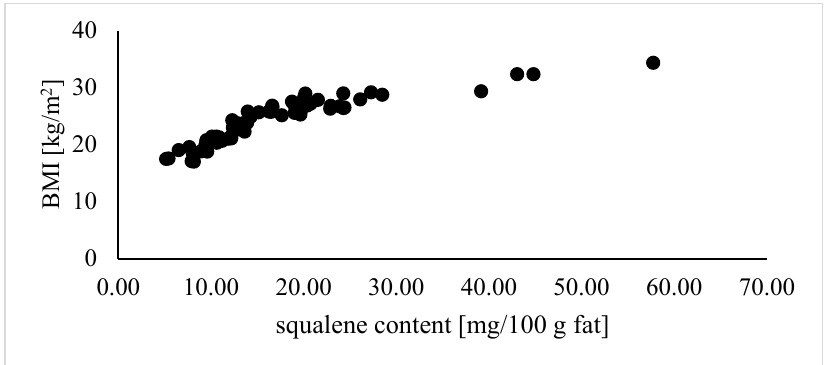
Figure 3. Correlation coefficients (r) calculated for the relationship between the BMI of lactating women and squalene content in human milk (correlation: r = 0.78). Table 2. Average content of fat, cholesterol, and squalene in human milk and formula milk of selected